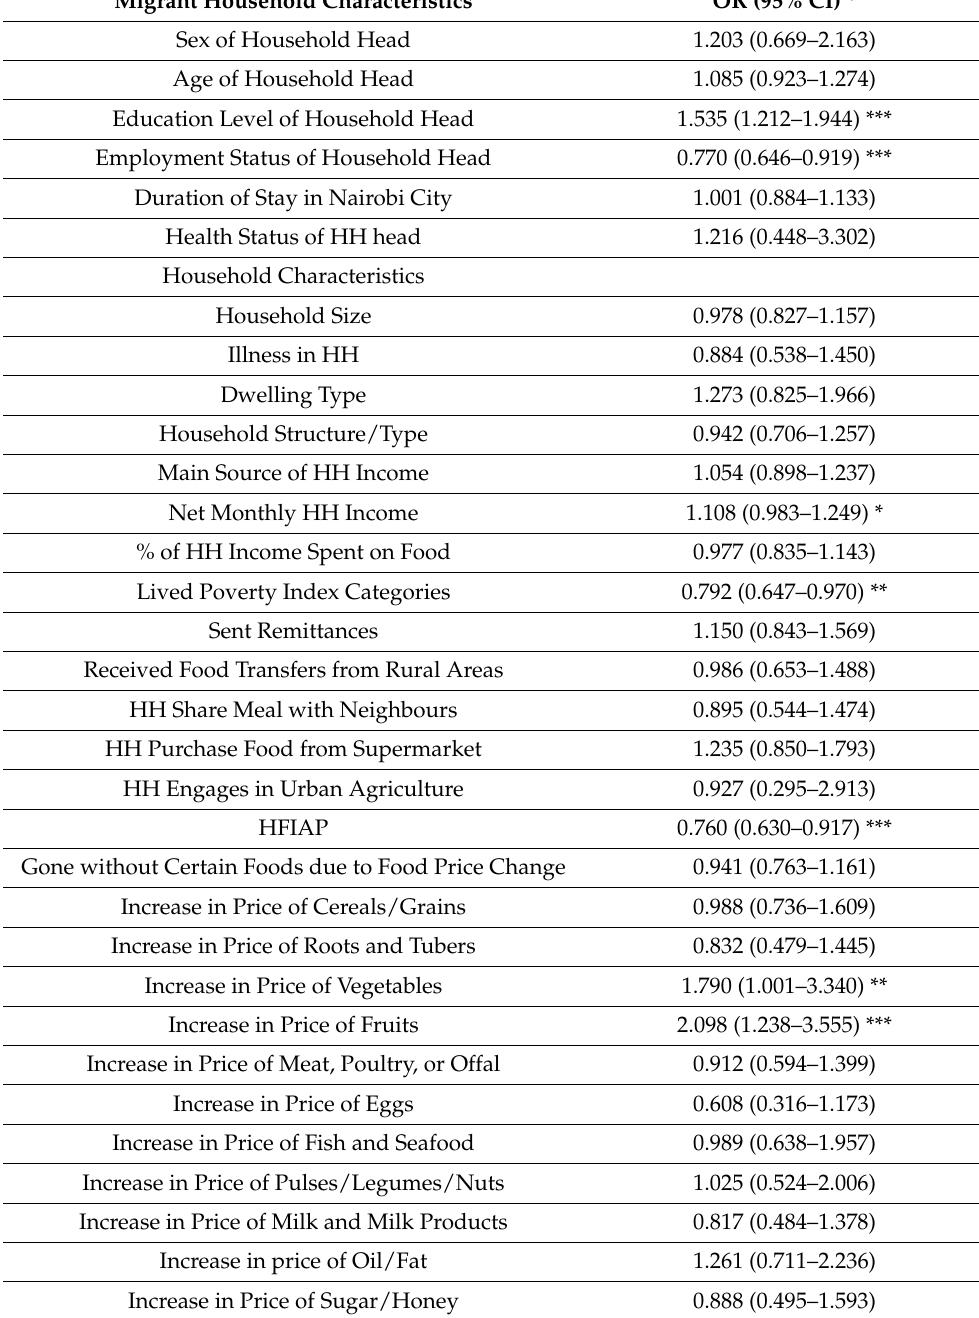
Table 8. Ordinal logistic regression of determinants of household diet